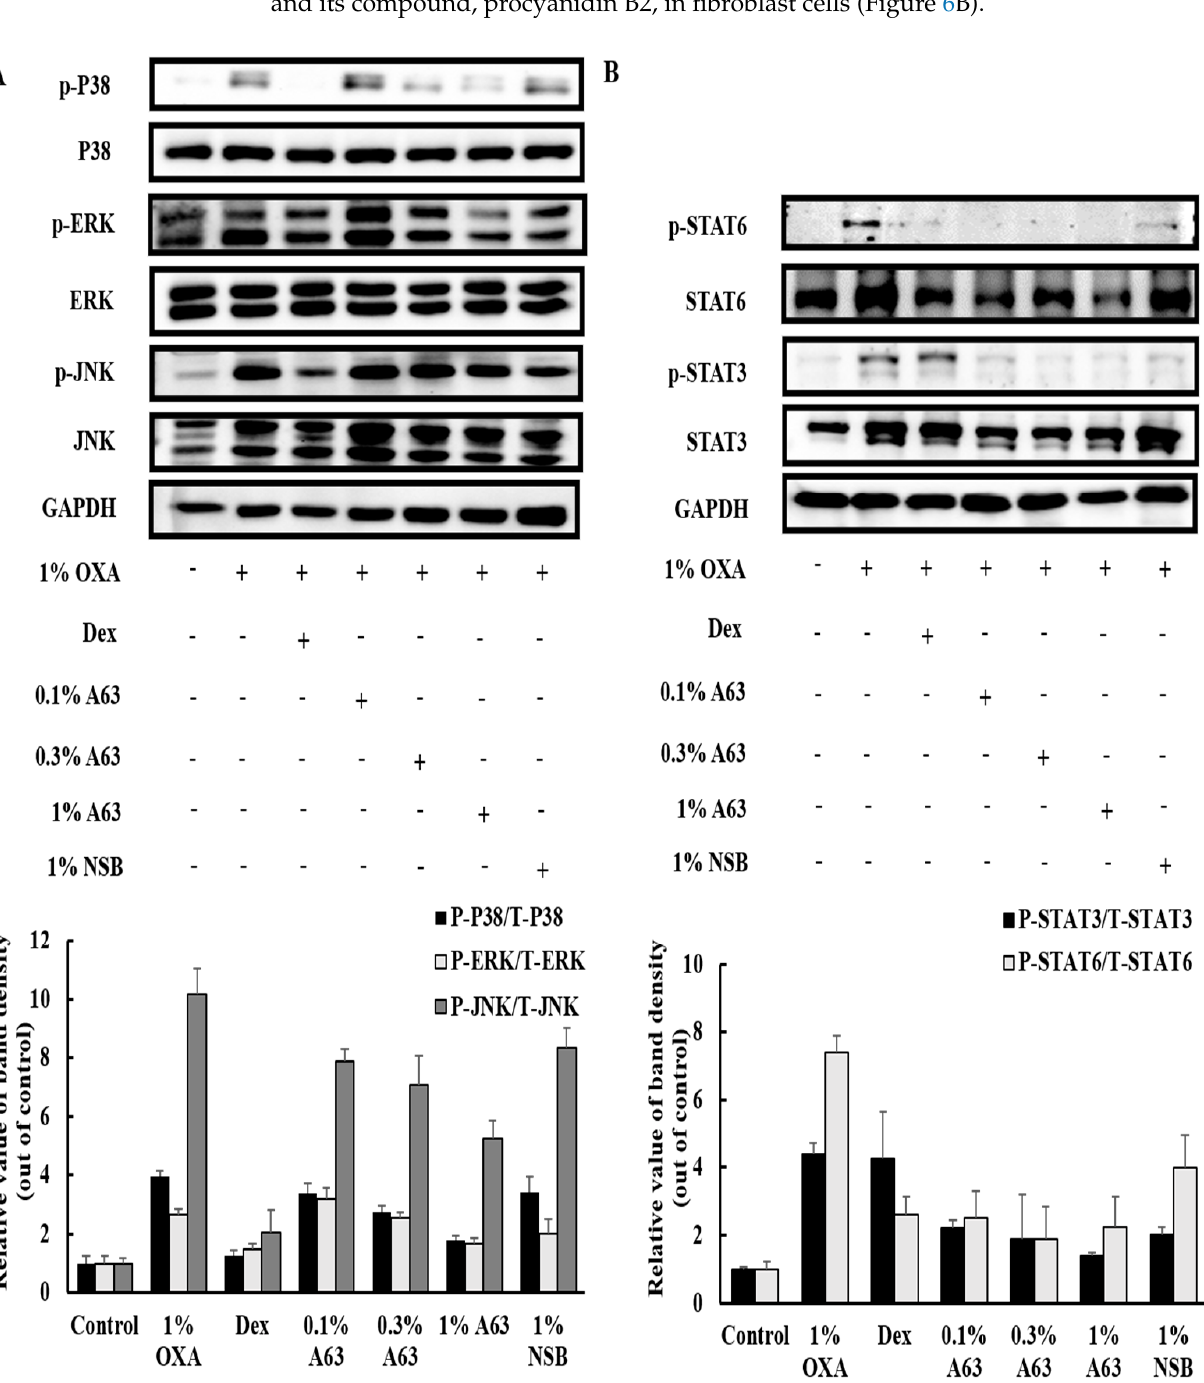
Figure 5. The activation of MAPK and STAT signaling was hindered by treatment with A63 extract. MAPK and STAT signaling pathways play crucial roles in the maturation of naive T cells, recruitment of immune cells, and secretion of atopic cytokines. A63 extract (1%) abolished the activation of MAPK signaling in atopic mice ( A ). STAT3/6 protein phosphorylation was suppressed dose-dependently upon A63 extract treatment ( B ).